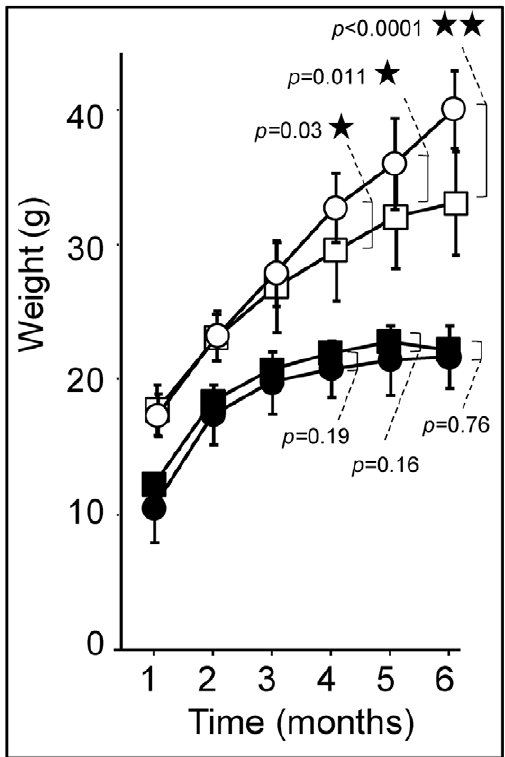
Figure 6. Harlequin mice are spared from the weight gain associated with chronic high fat feeding. Open symbols: wild type animals; dark symbols: Harlequin mice; squares: CD; circles: HFD. *: p , 0.05; **: p , 0.01 (Student’s two-tailed t test). Harlequin mice fed the CD (n=17 to 20); Harlequin mice fed the HFD (n=21); WT mice fed the CD (n=21); WT mice fed the HFD (n=21).